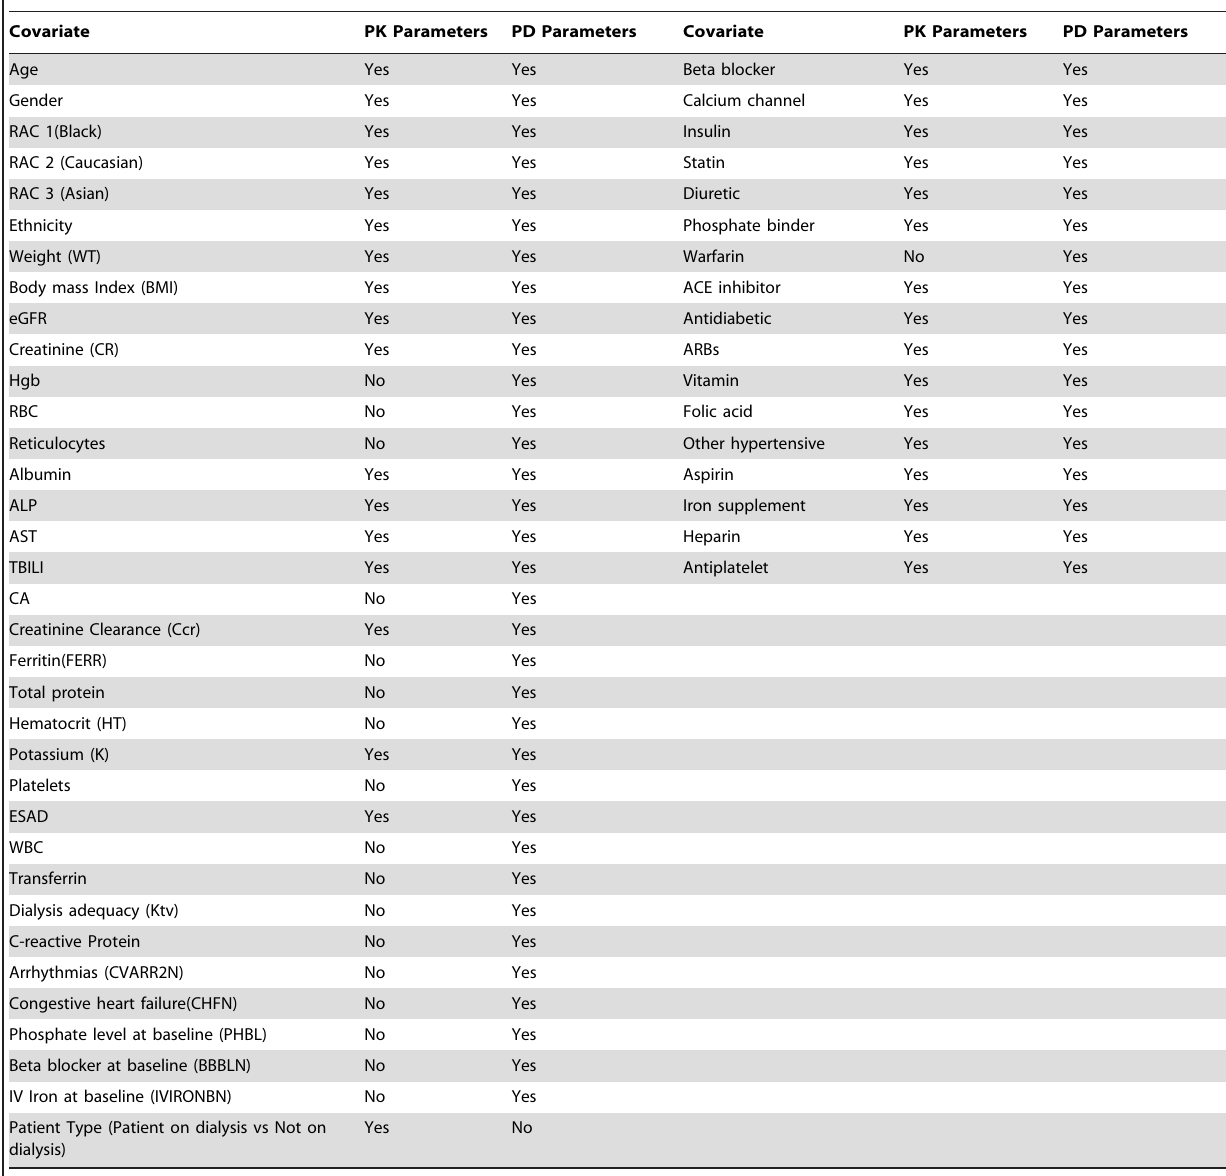
Table 4. Covariates evaluated on the PK and PD parameters of peginesatide.